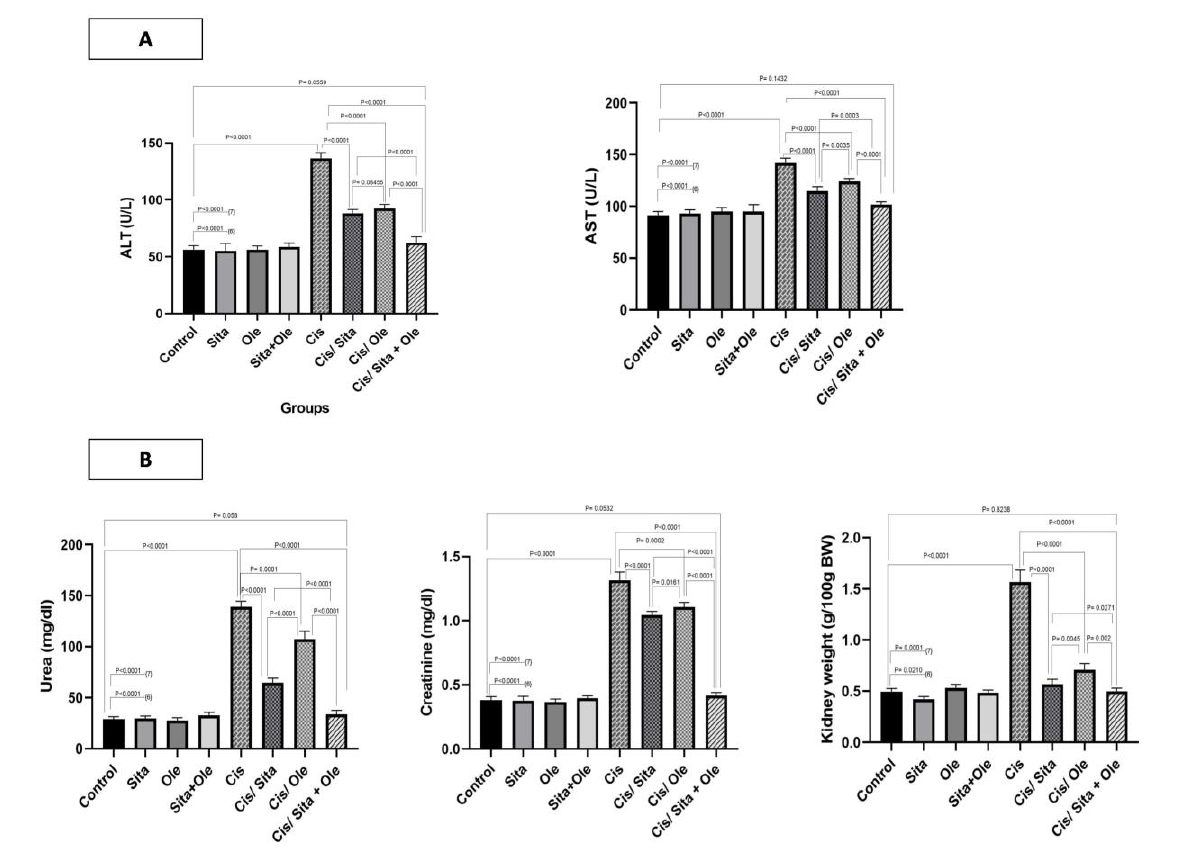
Fig. 1. Effect of cisplatin, sitagliptin, oleuropein and combination of them on liver functions (A) and nephrotoxicity indices (B) . Data are presented as means ± SD. P < 0.05 is considered statistically significant; one-way ANOVA followed by Bonferroni- corrected post hoc tests were